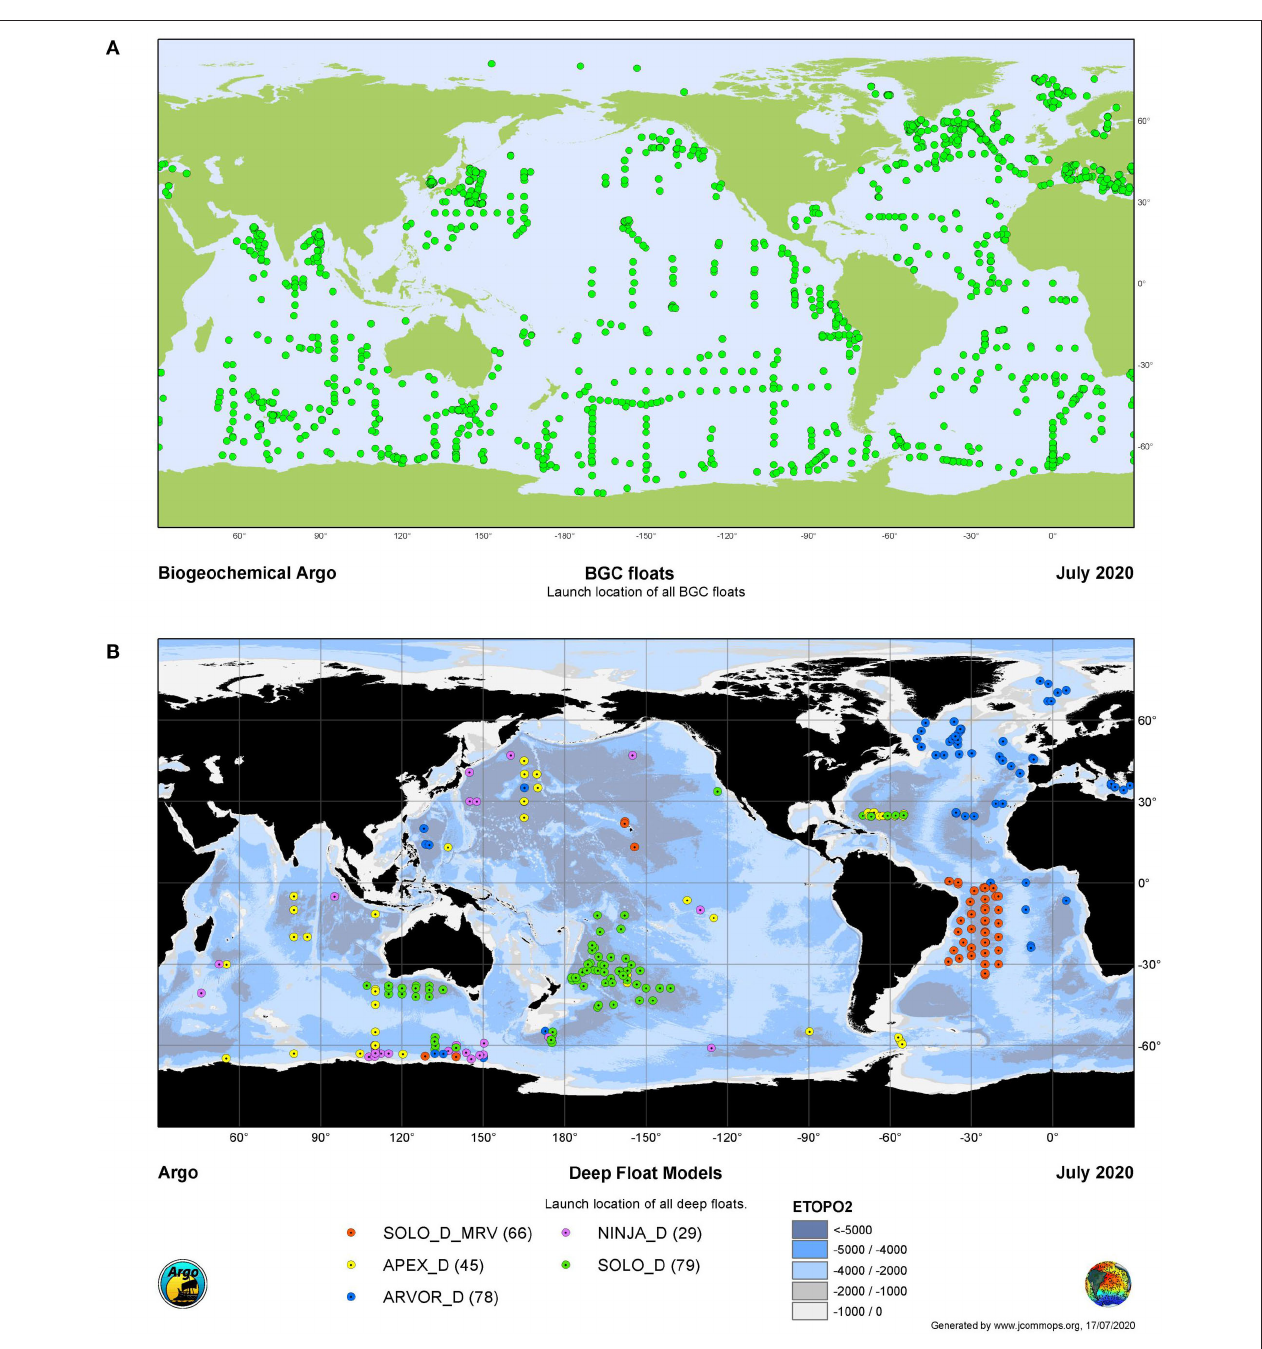
FIGURE 5 | Global map of all (A) BGC-Argo floats, and (B) Deep-Argo floats, as of July 2020. The locations shown are the launch location of the floats. [Source: JCOMMOPS].